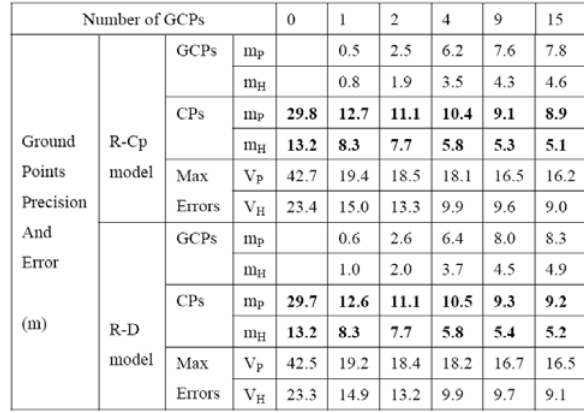
Table 2. stereo positioning accuracy statistics with